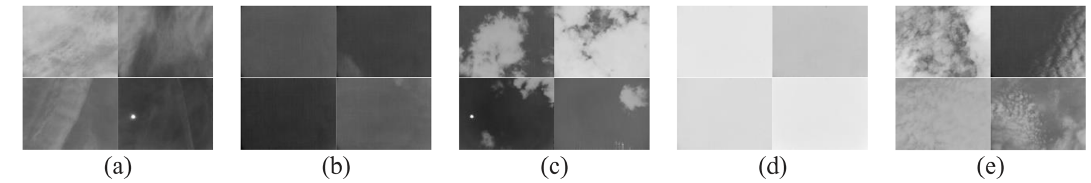
Figure 3. Sample images from the zenithal dataset: (a) cirriform clouds, (b) clear sky, (c) cumuliform clouds, (d) stratiform clouds and (e) waveform